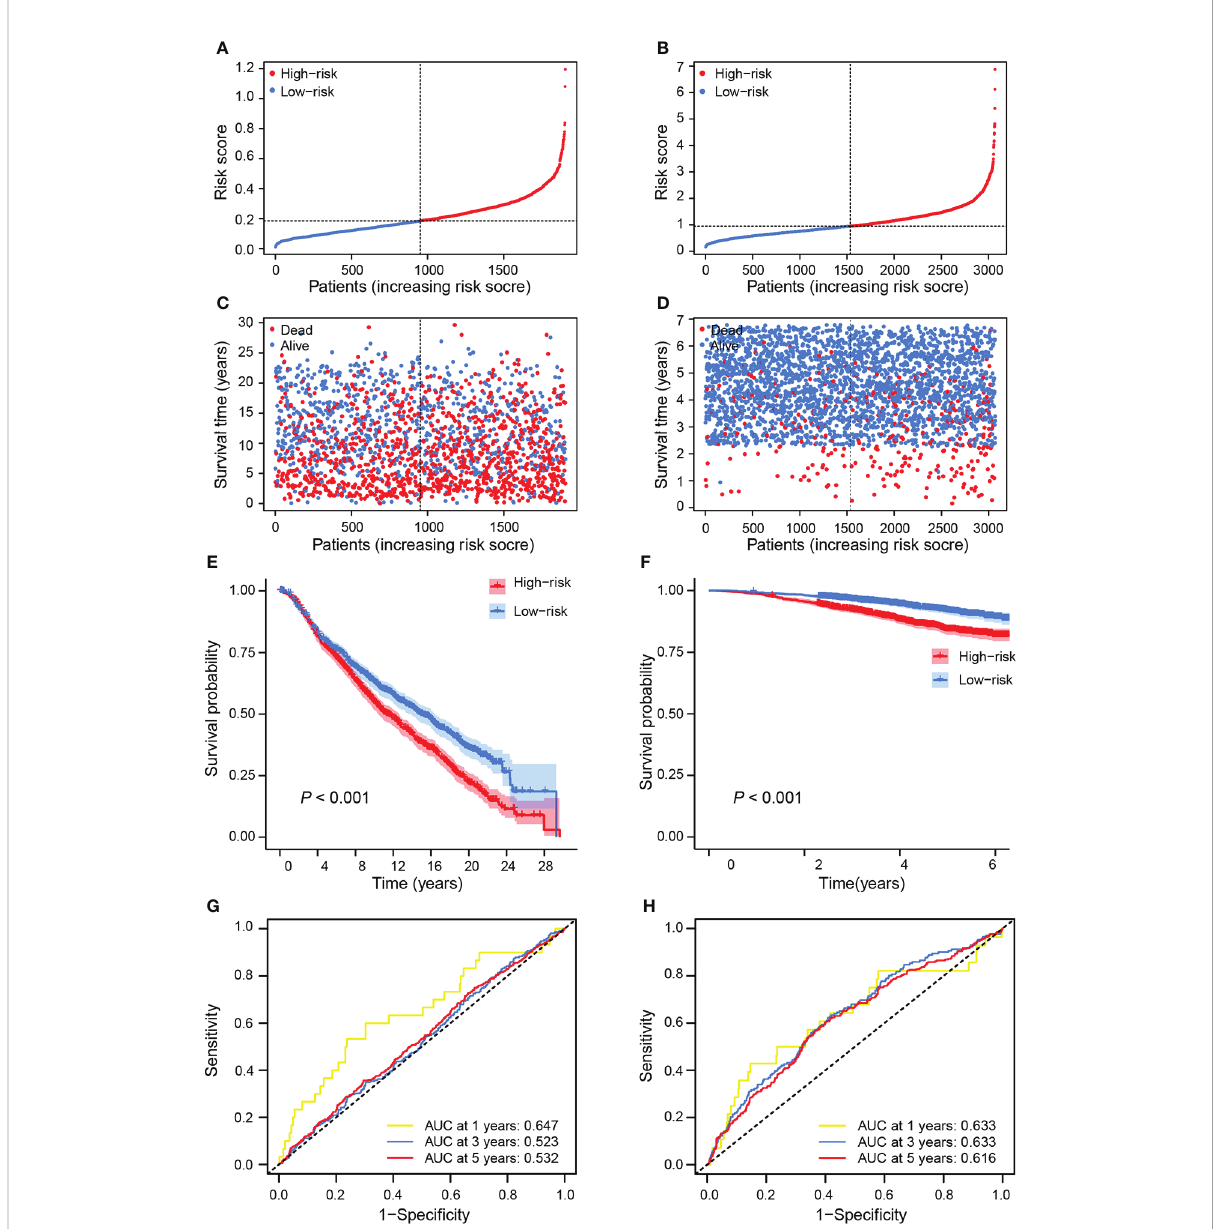
FIGURE 4 Validation of the prognostic value of risk score in independent cohorts. Breast cancer patients in the training set were separated into high-risk and low-risk groups based on the median value of risk score in the METABRIC cohort (A) and the GSE96058 cohort (B) . Breast cancer patients ’ survival status and risk score distribution in the METABRIC cohort (C) and the GSE96058 cohort (D) . Kaplan – Meier curves of OS between the high-risk and low-risk groups in the METABRIC cohort (E) and the GSE96058 cohort (F) . ROC curves showed the performance of risk score in predicting the 1-, 3-, and 5-year OS in the METABRIC cohort (G) and the GSE96058 cohort (H)